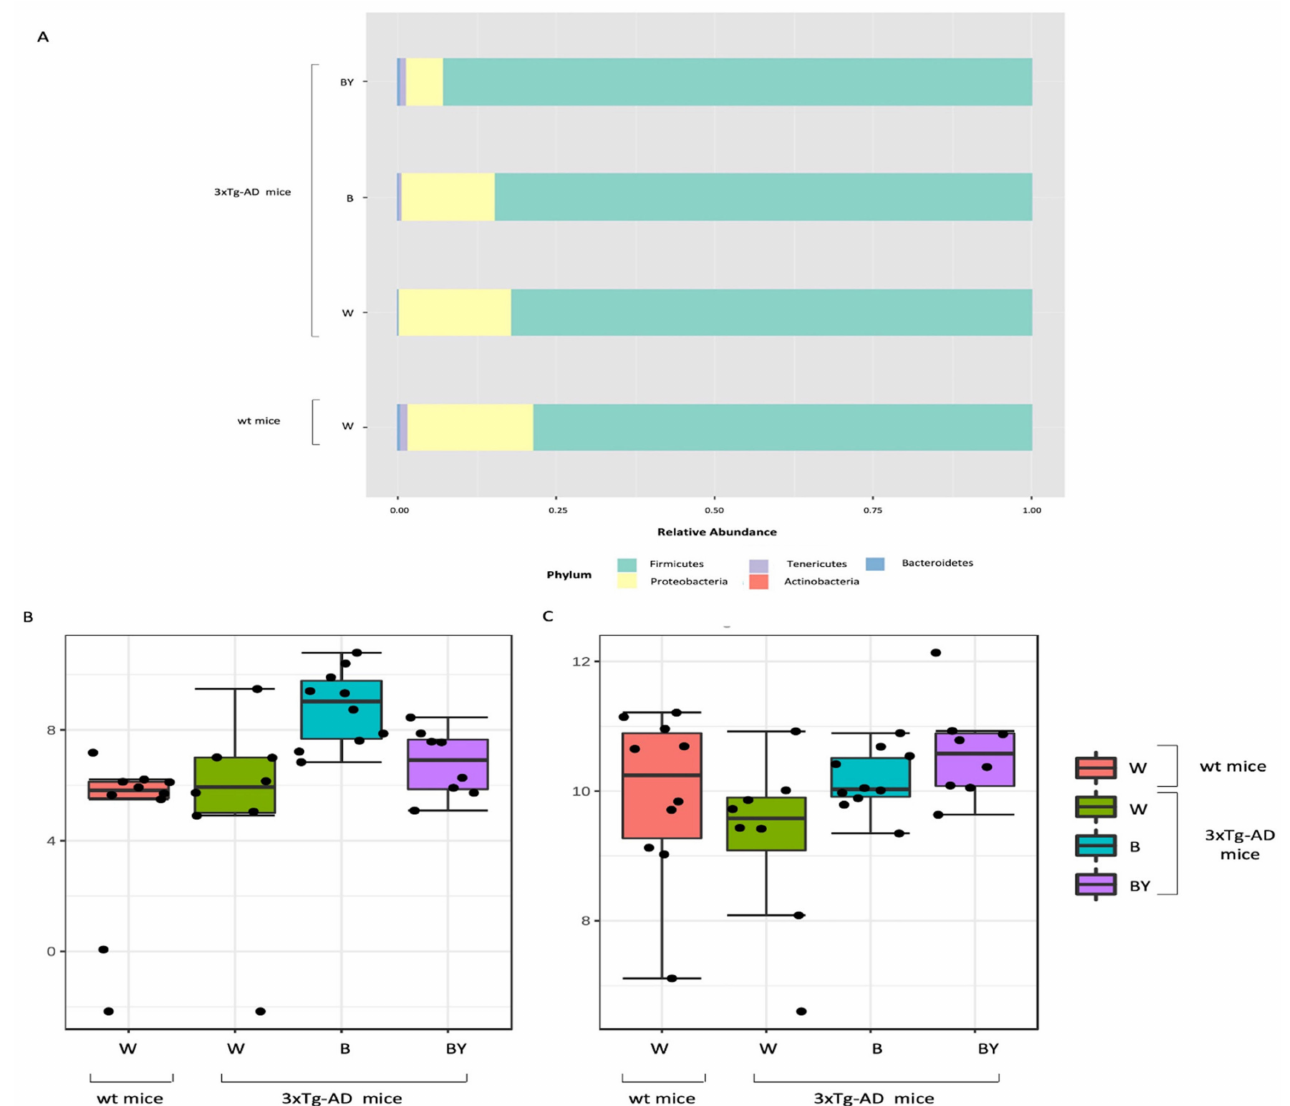
Figure 8. Taxonomic assignment of the gut bacterial communities. Phylum-level taxonomic assign- ment highlights a different microbial composition between the study groups. According to treatment, it is possible to observe an increase in Firmicutes and a reduction in Proteobacteria ( A ). Classical univariate analysis (i.e., t -test/ANOVA) was used to highlight significantly different taxa; at genus level, the genus Bilophila was increased in both the treated 3xTg-AD mice ( B ), while Ruminococ- caceae_unclassified abundance seemed to be restored by the treatments, especially by beer/yeast (BY) administration ( C